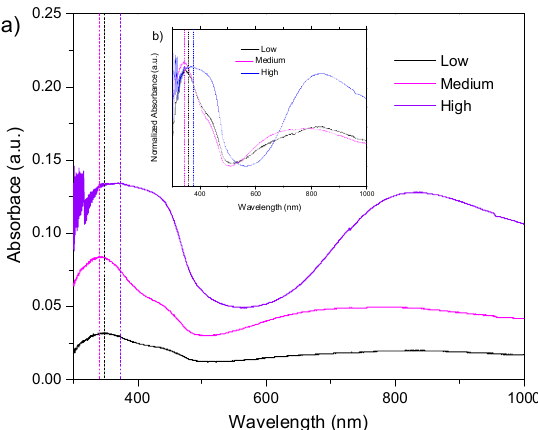
Figure 7. ( a ) UV–Vis-NIR absorbance spectra and ( b ) normalized UV–Vis-NIR absorbance spectra of PVA–PANI thin films activated with 1% GA for 30 min.